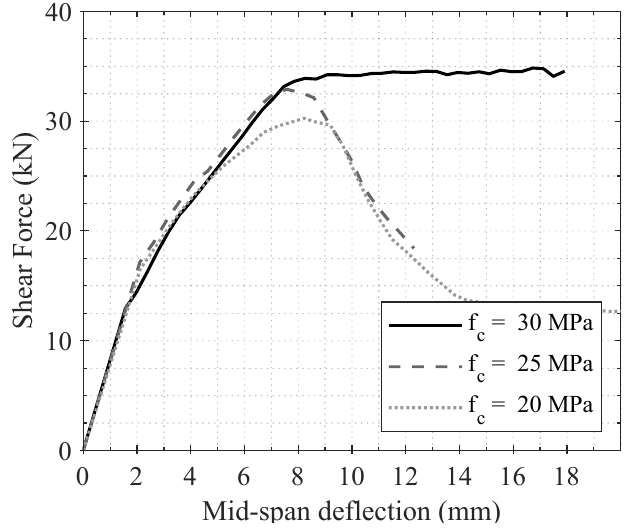
Figure 15. Effect of concrete strength on the behaviour of specimen S1-C.